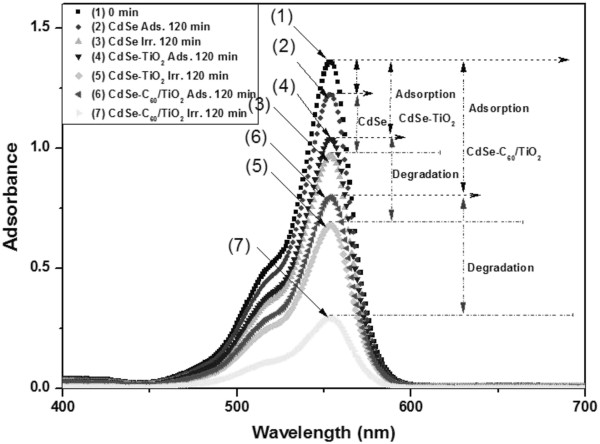
UV–vis spectra of the Rh.B concentration against CdSe, CdSe-TiO2, and CdSe-C60/TiO2 composites.